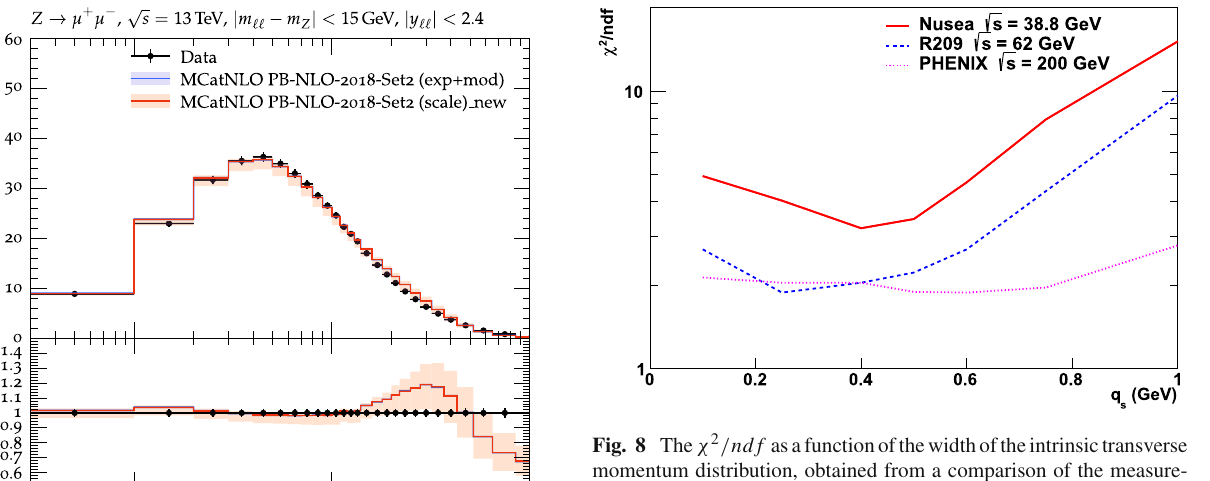
tal measurements for different center-of-mass energies from NuSea [42,43], R209 [41] and PHENIX [40]. The PB-TMDs